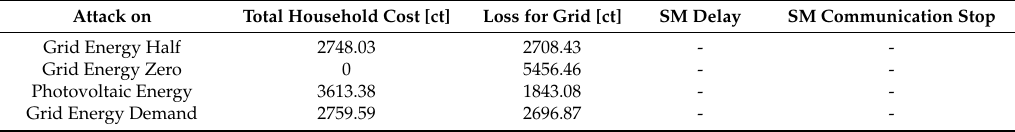
Table 8. Results of the simulation of confidentiality attack injection.